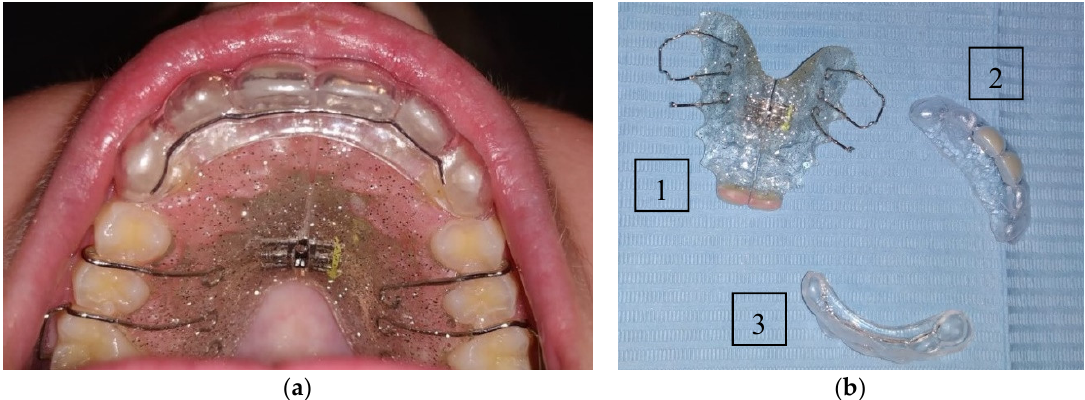
Figure 5. The customized splint placed over the Hawley appliance: ( a ) appliance in place; ( b ) The three intra-oral devices fabricated for this clinical case, the Hawley appliance with central expansion screw and two central incisors (1), the Trumpet edentulous anterior tooth appliance — TEATA (2), the customized splint (3).